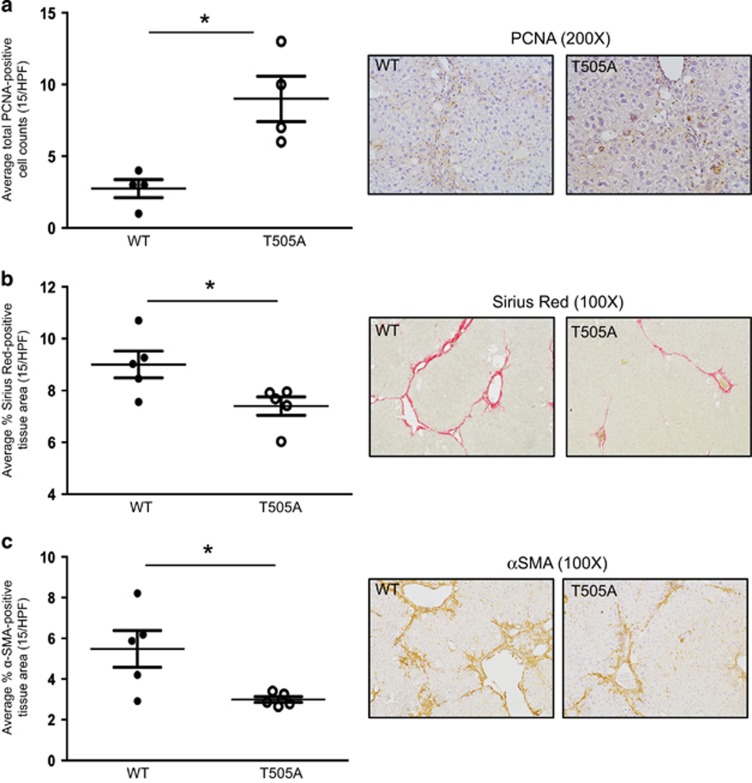
Increased hepatocyte proliferation and reduced fibrosis in RelA T505A mice following chronic CCl4 administration. (a–c) Mean number of cells/field scoring positive for PCNA (a), collagen (sirius red, SR) (b) and myofibroblasts (αSMA) (c) in WT and T505A liver tissue sections following 8 weeks of chronic CCl4 administration. Representative images of each are shown. Photomicrographs are at × 200 (PCNA) and × 100 (SR and αSMA) magnification. *P<0.05 (Unpaired Student's t-test).